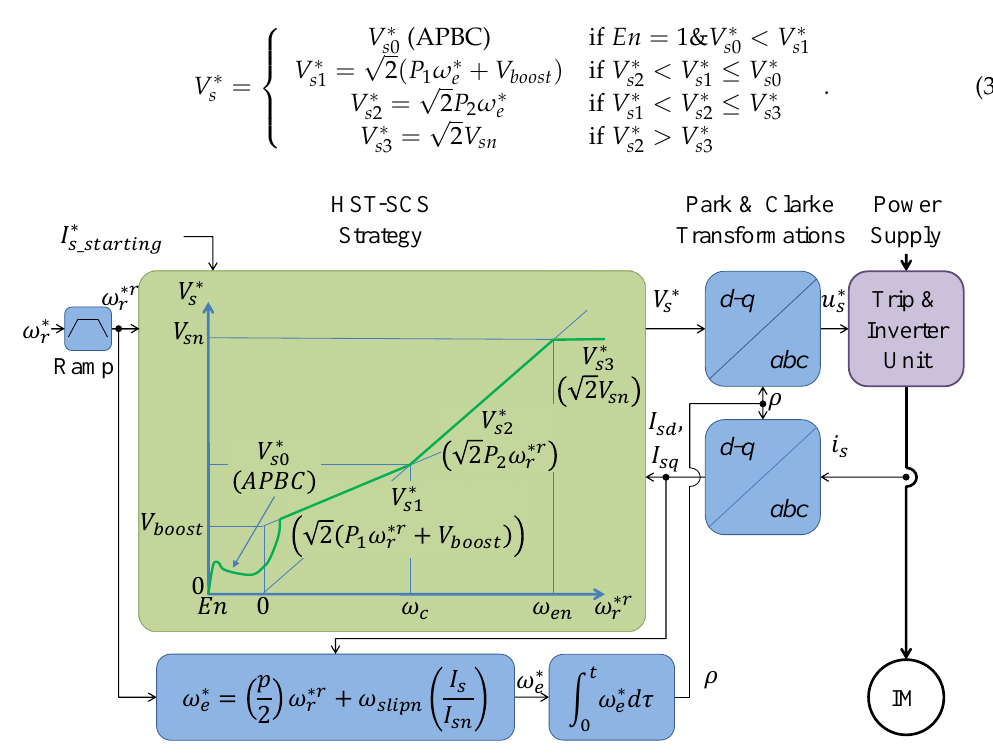
Figure 2. Basic HST-SCS block diagram for IM